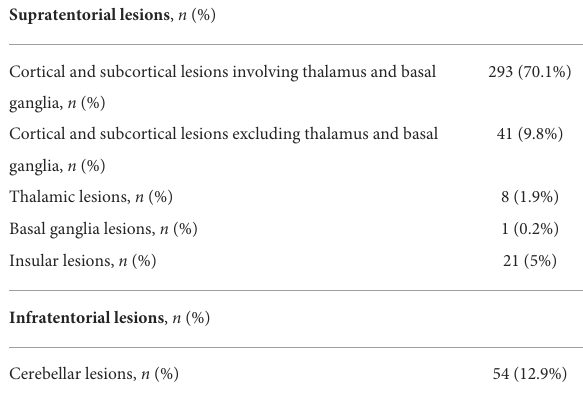
TABLE 1 Characterization of demographic and clinical information. TABLE 2 Characterization of stroke